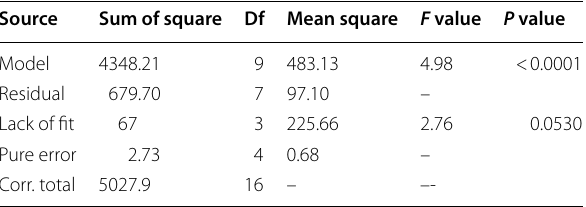
Table 3 ANOVA for the quadratic model developed for the optimization of gallic acid lipid nanoparticles